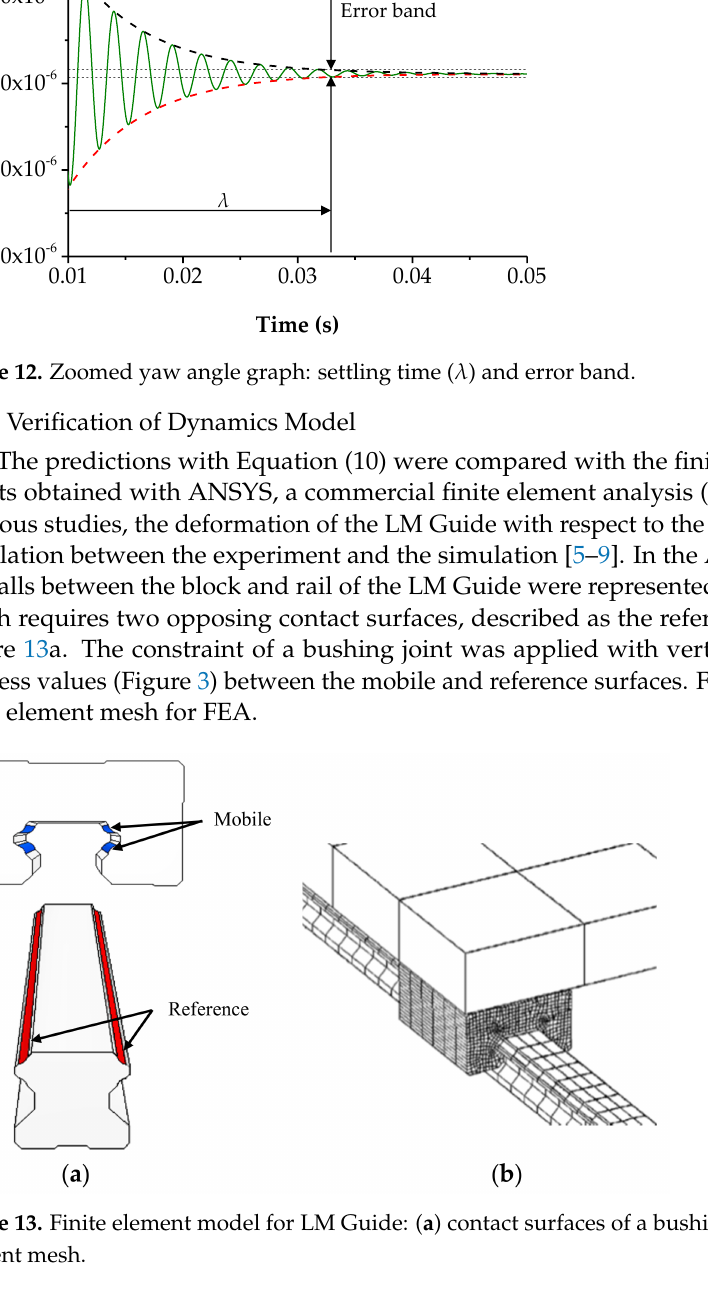
Figure 11. Yaw angle vs. force offset for various platforms.